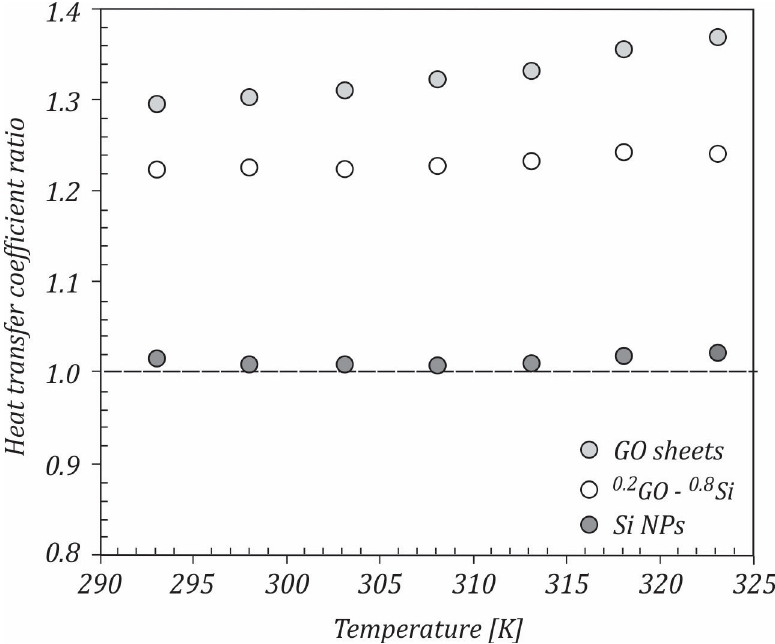
Figure 11. Heat transfer coefficients ratios.